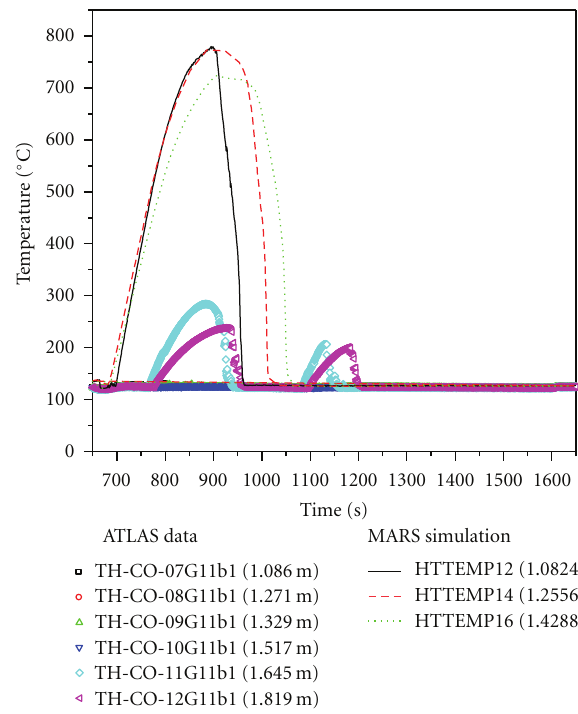
Figure 5: Comparison of measured PCTs with code predictions during LB-CL-05.